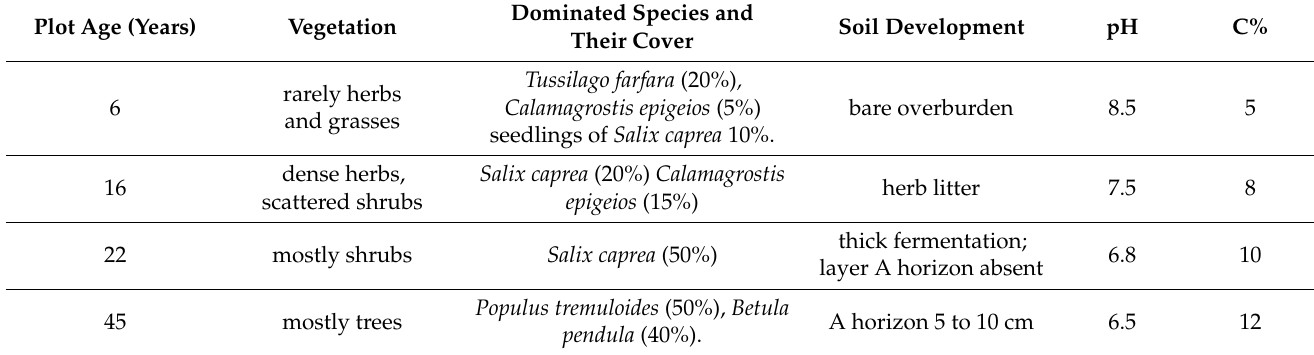
Table 1. Characteristics of the studied sites based on [5,13,25]. Plot age is expressed in years after the heaping process, soil parameters refer to topsoil 0–10 cm, pH refers to pH in H 2 O, C% refer to percentage of soil organic